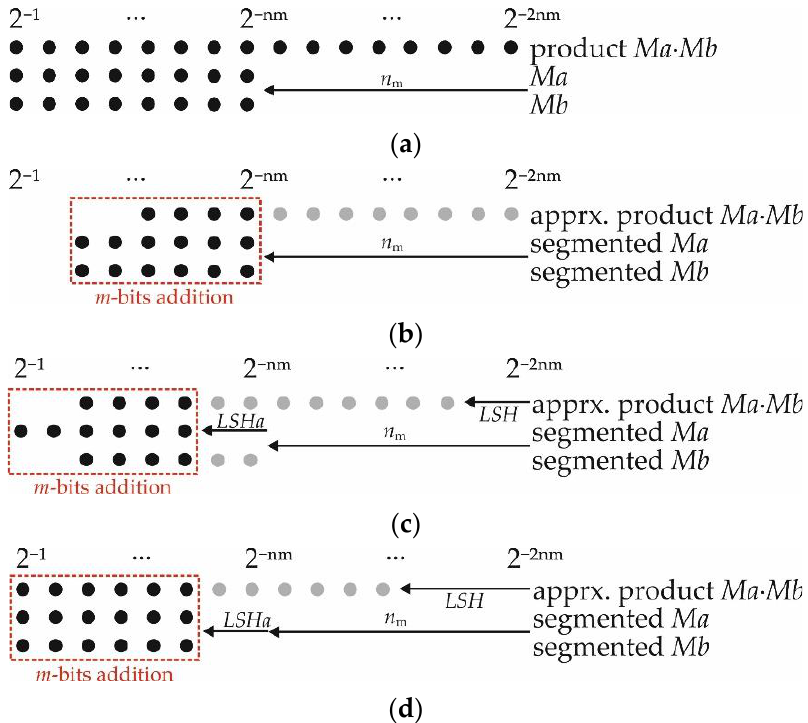
Figure 6. Signals alignment for the mantissa product in ( a ) the exact case, and the approximate static segmented cases with ( b ) α Ma = 0 , α Mb = 0, ( c ) α Ma = 1 , α Mb = 0, and ( d ) α Ma = 1 , α Mb = 1. In this example, we consider n m = 8 bits and m = 6 bit.